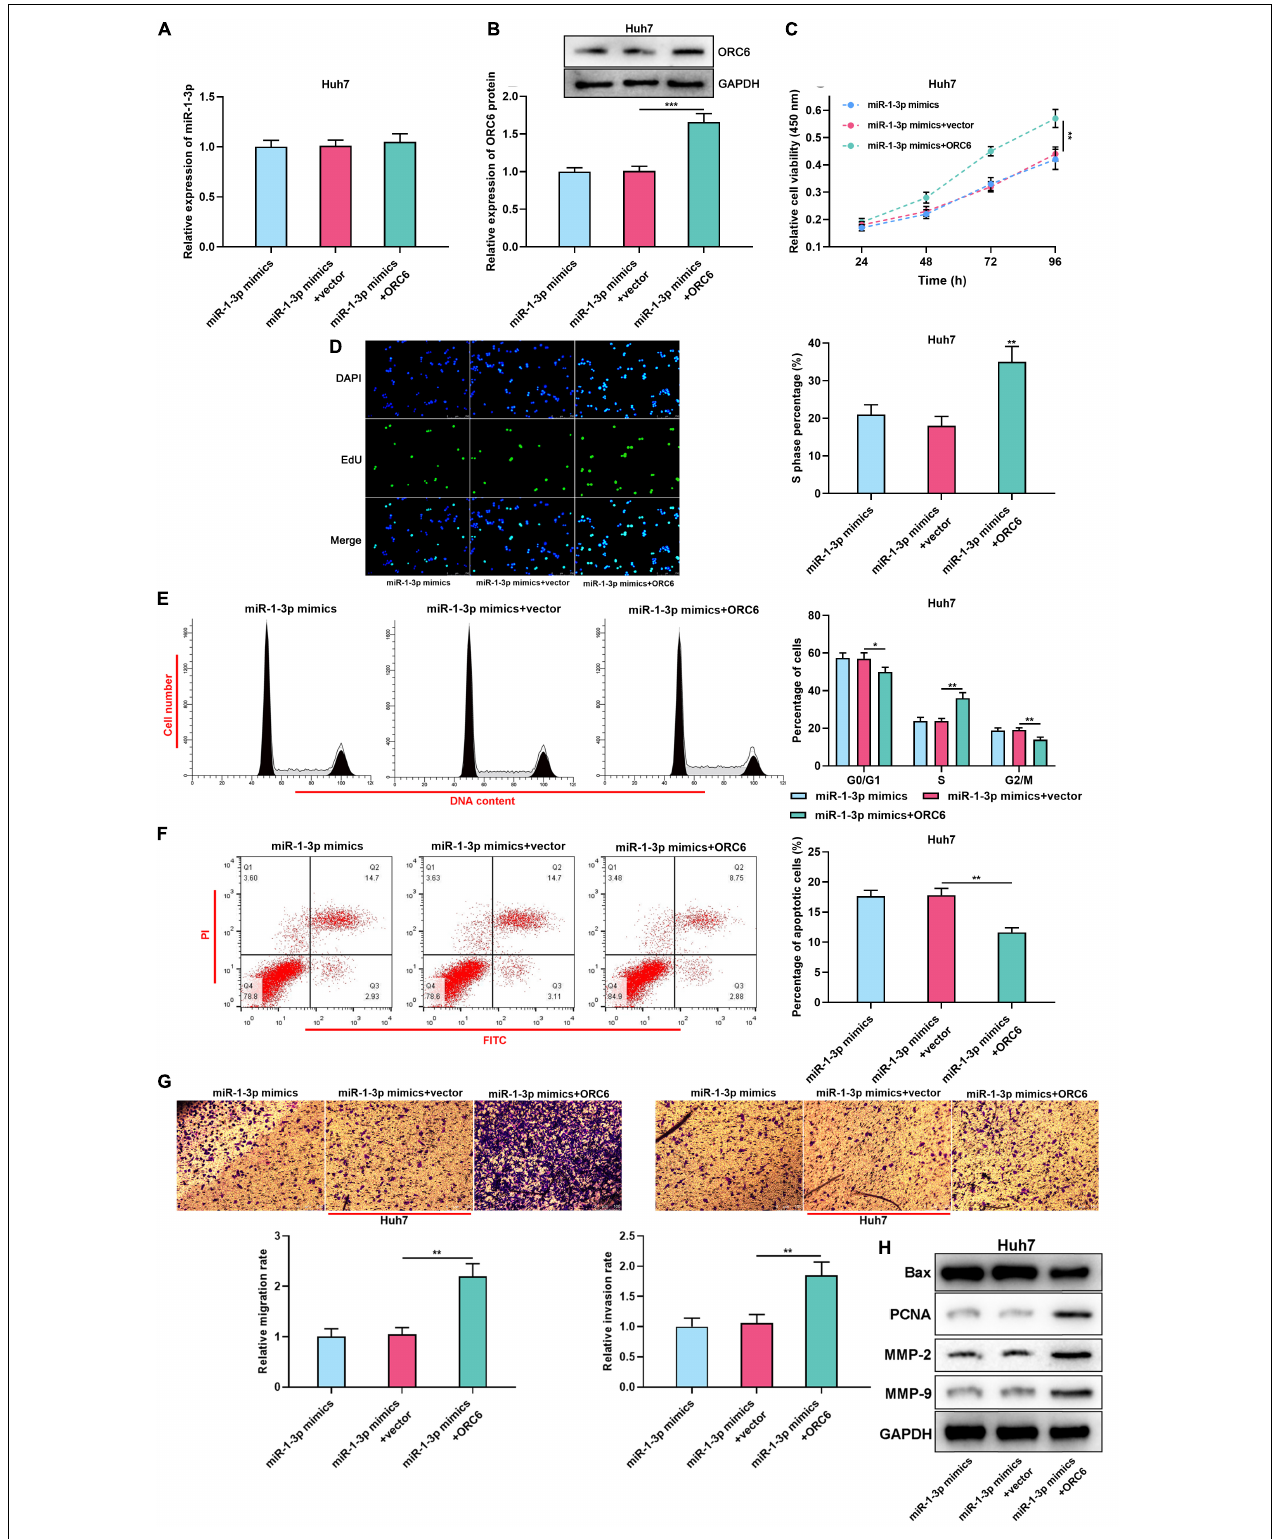
FIGURE 5 | MiR-1-3p/ORC6 axis regulates the malignant biological behaviors of Huh7 cells. Huh7 cells were transfected with miR-1-3p mimics, or miR- 1-3p mimics + empty vector, or miR-1-3p mimics + ORC6 overexpression plasmids, respectively. (A) The relative expression of miR-1-3p was detected with qRT-PCR.